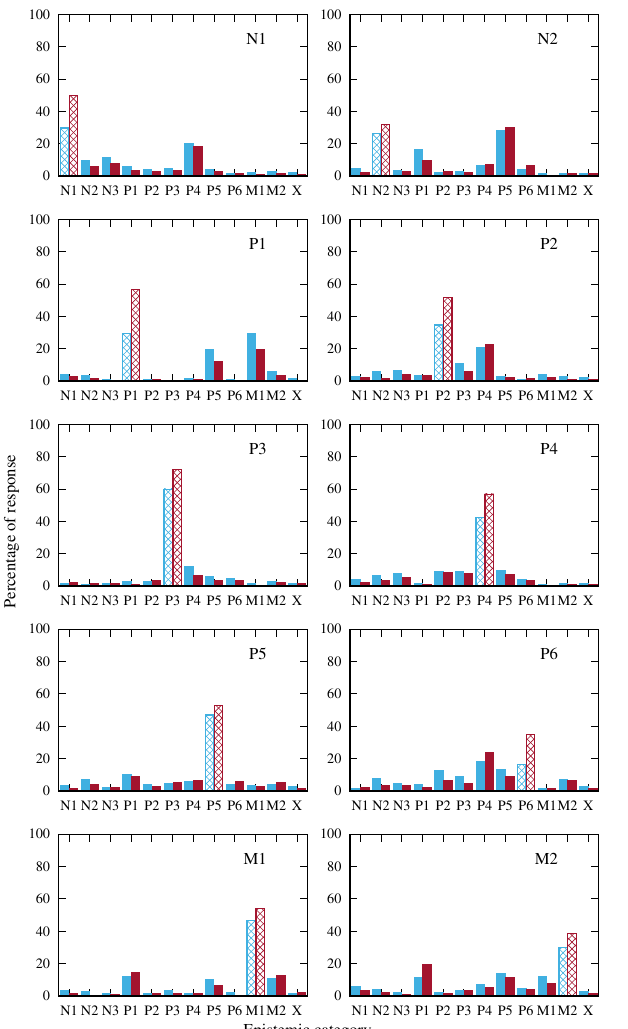
FIG. 3. Aggregate distribution of responses to all propositions corresponding to each epistemic category for both surveys. The percentage distributions for the whole samples are shown. The light blue bars correspond to Survey 1 while the red bars correspond to Survey 2. The correct response is marked with a hashed pattern while other responses are marked in solid. The case of no responses is shown as “ X. ”